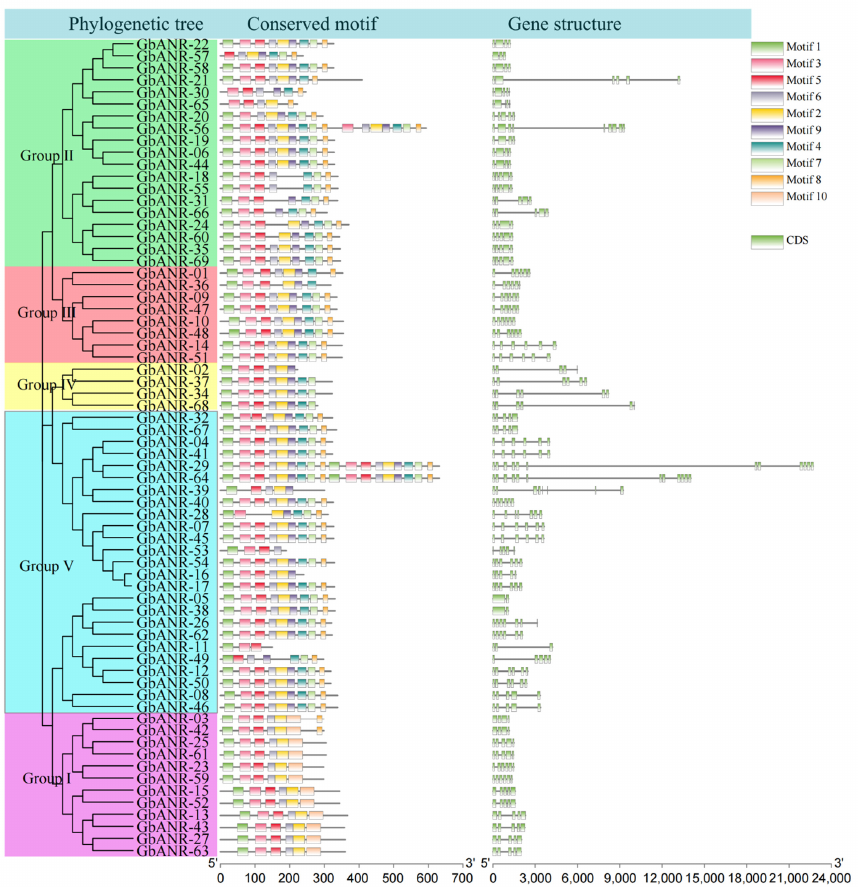
Figure 3. Evolutionary tree, gene structure, and conserved motif analysis of the G. barbadense ANR gene family.